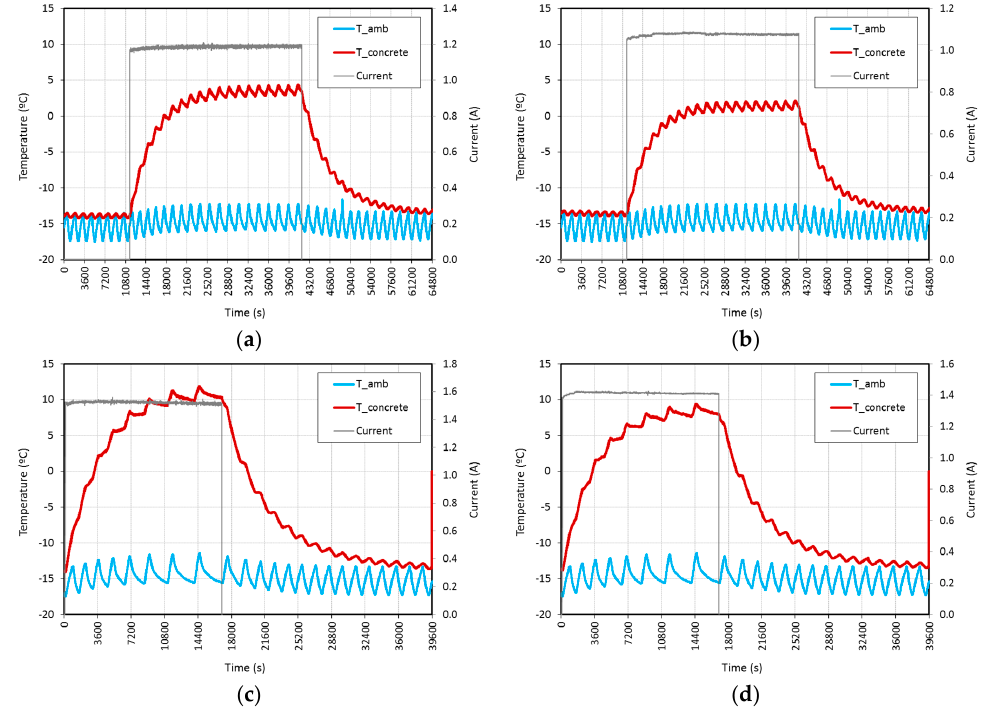
Figure 8. Curing tests performed at fixed voltages of: ( a ) 20 V AC; ( b ) 20 V DC; ( c ) 25 V AC; ( d ) 25 V DC.